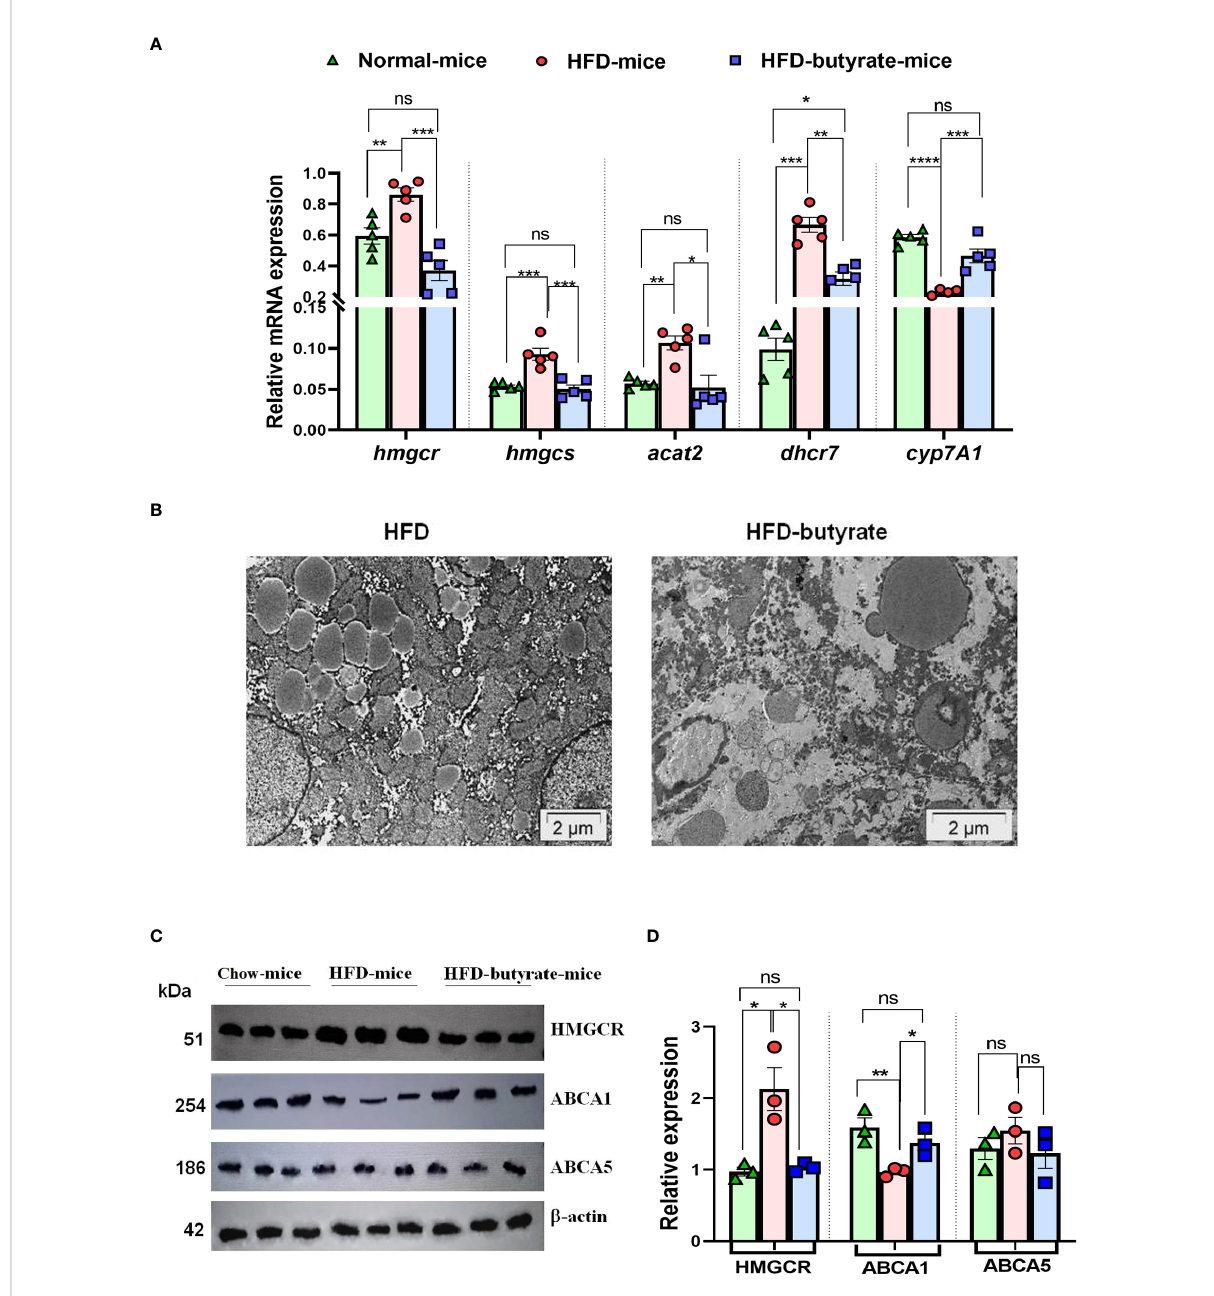
FIGURE 2 Analysis of hepatic expression of cholesterol metabolic genes by qPCR, lipid droplet status in the liver, and HMGCR, ABCA1, and ABCA5 expression by Western blot in chow mice, HFD mice, and HFD butyrate mice. Hepatic expression of cholesterol metabolic pathway: hmgcr , hmgcs , dhcr7 , acat-2 , and cyp7A1 were studied in all the groups by qPCR (A) . TEM images of the liver sections showing lipid droplets. The sections were visualized under a FEI Tecnai 12 Biotwin transmission electron microscope (FEI, Hillsboro, OR, USA) at an accelerating voltage of 100 kV. Scale bar in the image is 2 µm (B) . Analysis of hepatic expression of HMGCR, ABCA1, and ABCA5 by Western blot (C) . Densitometry was done using ImageJ showing relative expression with respect to b -actin control (D) . N = 5/group; data are presented as mean ±SE. The experiment was repeated thrice. **** represents p<0.0001, *** represents p < 0.001, ** represents p < 0.01, * represents p < 0.05, ns represents not signi fi